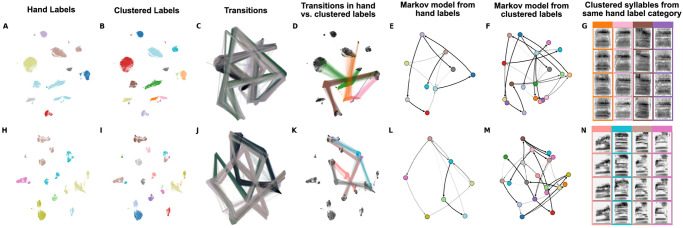
Latent comparisons of hand- and algorithmically-clustered Bengalese finch song.A-G are from a dataset produced by Nicholson et al., [9] and H-N are from a dataset produced by Koumura et al., [10] (A,H) UMAP projections of syllables of Bengalese finch song, colored by hand labels. (B,I) Algorithmic labels (UMAP/HDBSCAN). (C, J) Transitions between syllables, where color represents time within a bout of song. (D,K) Comparing the transitions between elements from a single hand-labeled category that comprises multiple algorithmically labeled clusters. Each algorithmically labeled cluster and the corresponding incoming and outgoing transitions are colored. Transitions to different regions of the UMAP projections demonstrate that the algorithmic clustering method finds clusters with different syntactic roles within hand-labeled categories. (E,L) Markov model from hand labels colored the same as in (A,H) (F,M) Markov model from clustered labels, colored the same as in (B,I). (G,N) Examples of syllables from multiple algorithmic clusters falling under a single hand-labeled cluster. Colored bounding boxes around each syllable denotes the color category from (D,K).